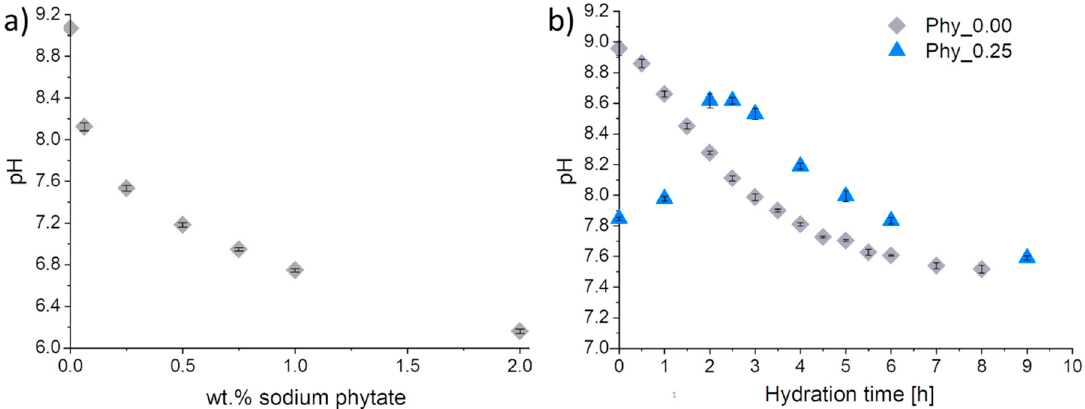
Figure 6. The pH measurements of ( a ) 0.2 M Na 2 HPO 4 aqueous solutions containing variable amounts of sodium phytate (wt.% related to the powder content of the corresponding cement pastes) and ( b ) cements composed of α –TCP and CDHA (weight ratio 9:1) with 0 and 0.25 wt.% sodium phytate; a 0.2 M Na 2 HPO 4 aqueous solution was used as the mixing liquid with an L / P of 1.2 ml / g Powder . The measurements were performed at T = 37 ◦ C; three independent measurements were run for each sample, and the error bars represent the standard deviation.